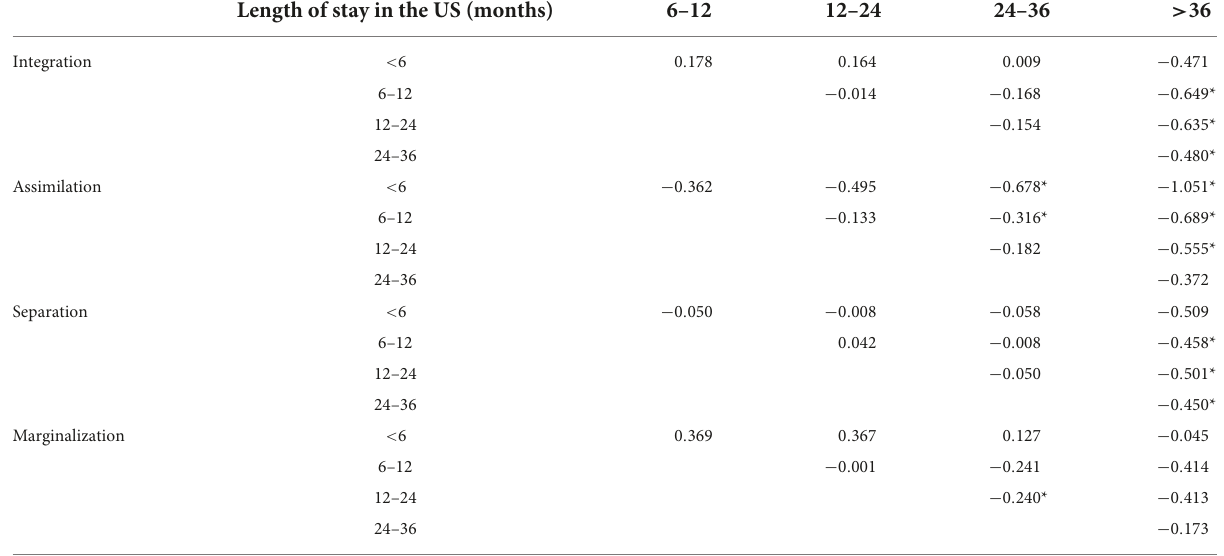
TABLE 7 Post hoc of length of stay in the US on intercultural adaptation strategies. Length of stay in the US